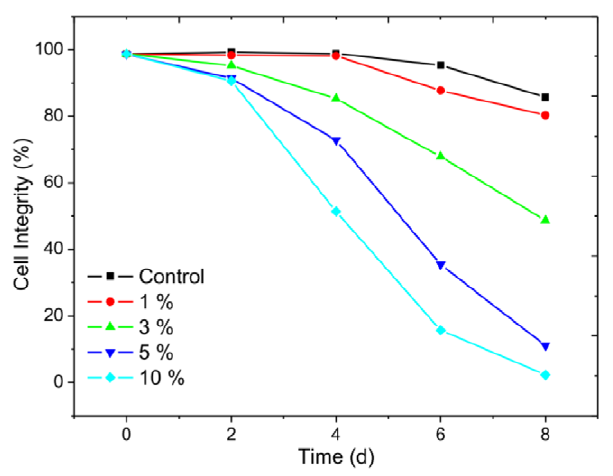
Figure 1. Cell viability for M.aeruginosa FACHB-905 with and without exposure to Streptomyces sp. HJC-D1 culture broth.